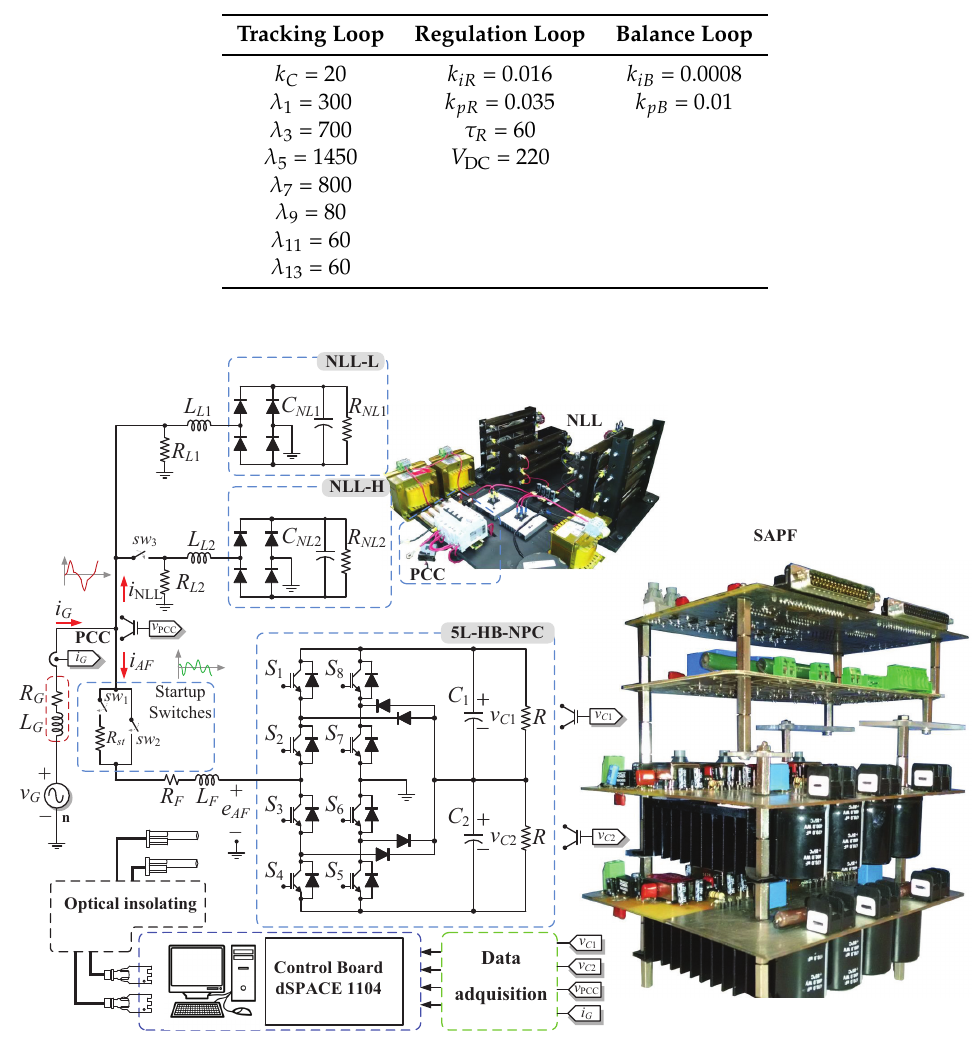
Figure 4. Experimental setup of the 5L-HB-NPC as the